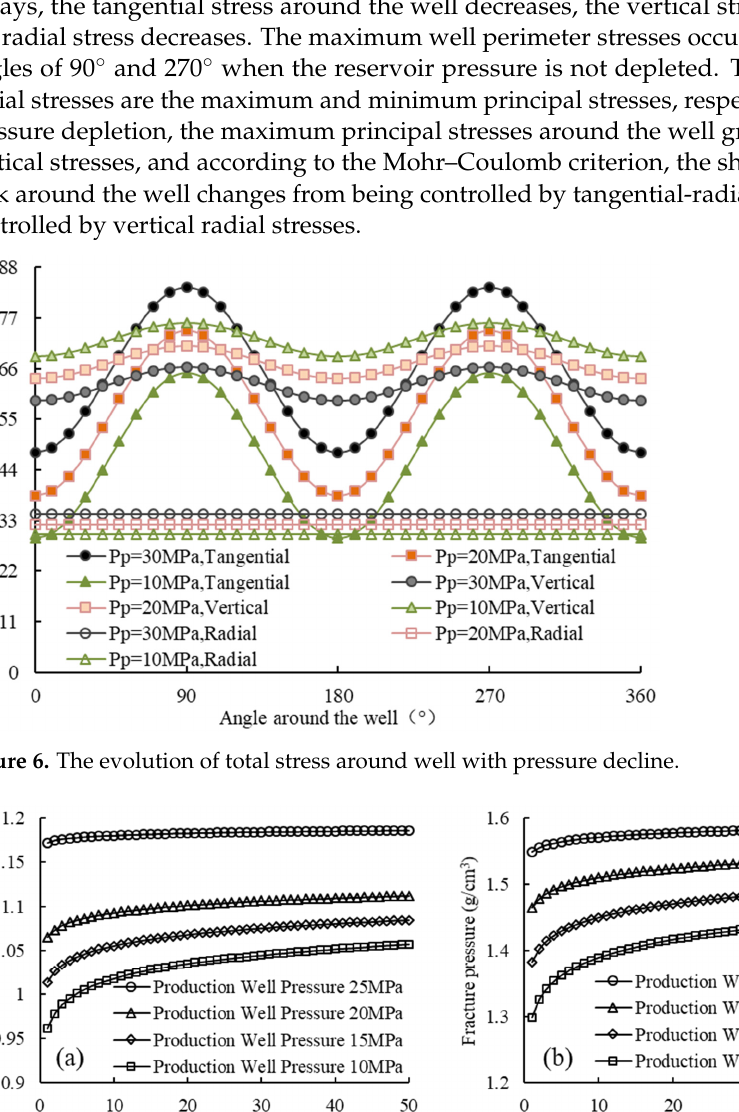
Figure 5. The evolution of in situ stress magnitude and direction with pressure decline.